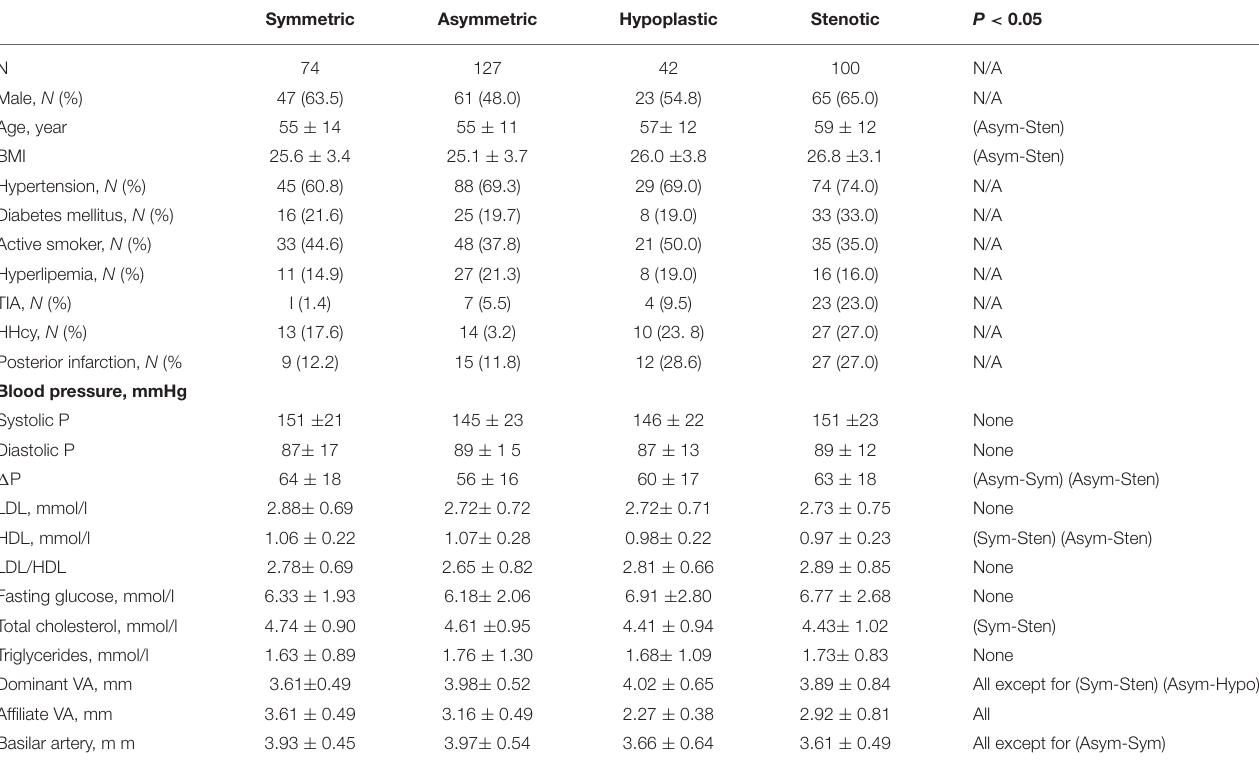
TABLE 1 | Baseline characteristics of the study population and morphometry of intracranial vertebrobasilar arteries in symmetric, asymmetric, hypoplastic, and stenotic groups. Symmetric Asymmetric Hypoplastic Stenotic P <